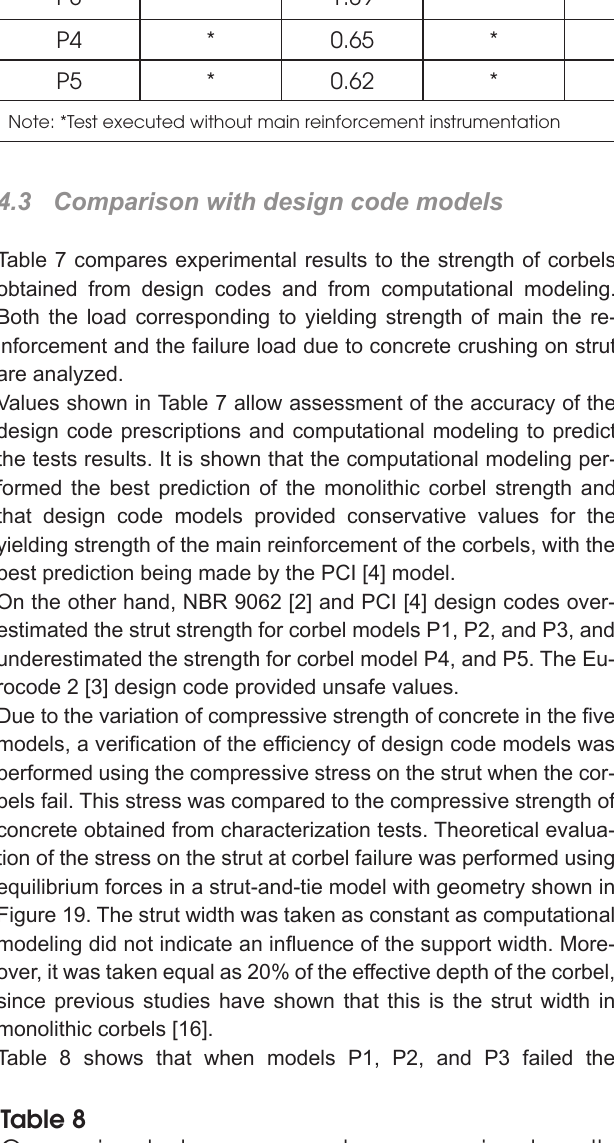
Comparison between concrete compressive